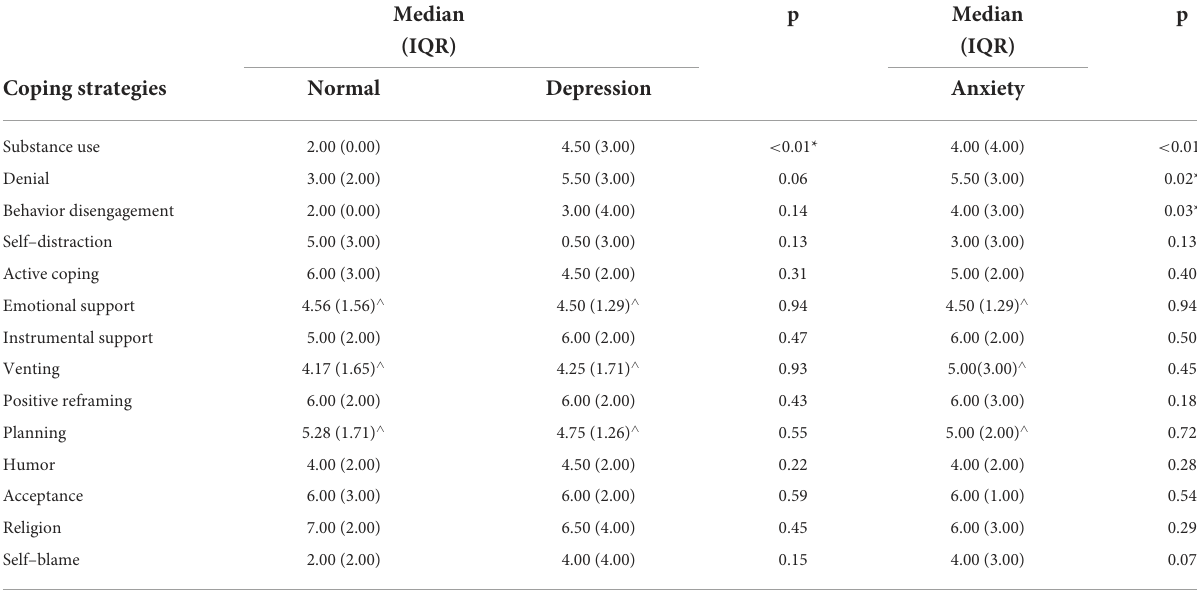
TABLE 5 The median and Interquartile Range (IQR) scores of different coping strategies utilized by participants who reported normal psychological functioning compared to those who reported having depressive and anxiety symptoms.